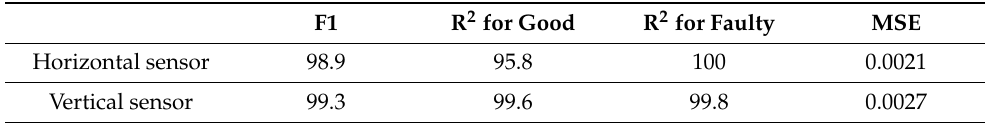
Table 1. Summarization for results reached during research.